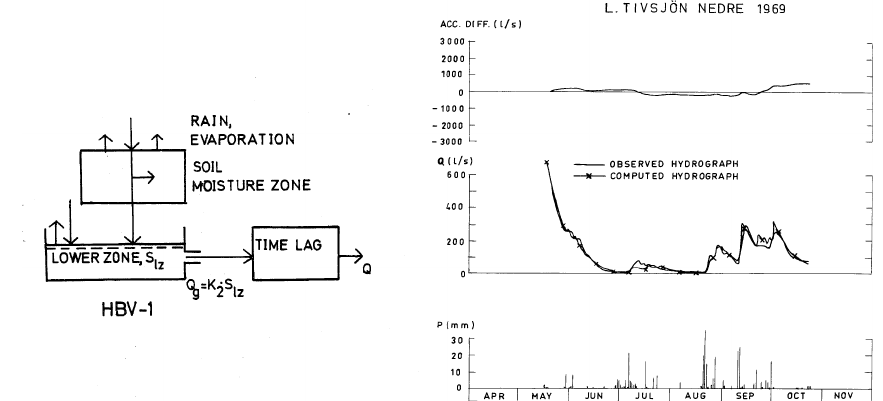
Figure 4. A sketch of the very first version of the HBV model and the very first successful simulation of runoff based on data from the Lilla Tivsjön basin (from Bergström, 1976).